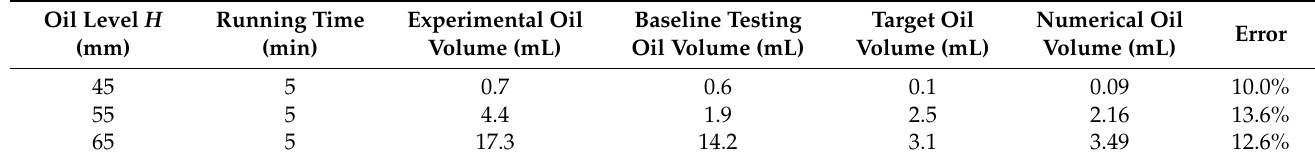
Table 6. Experimental and numerical flow data versus oil